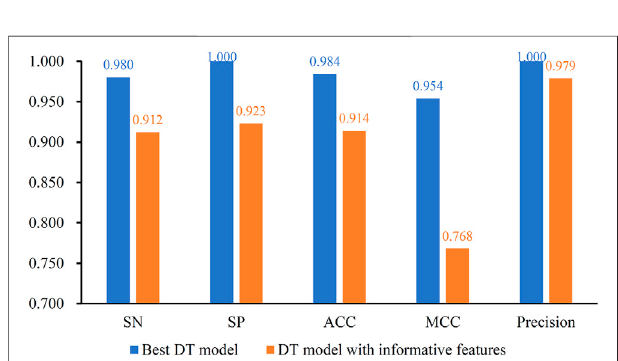
FIGURE 2 | IFS curves obtained by DT classi fi cation models on the top 1000 features of the COVID-19 dataset. The model produced the highest F1- measure of 0.990 when the top 50 features were used.